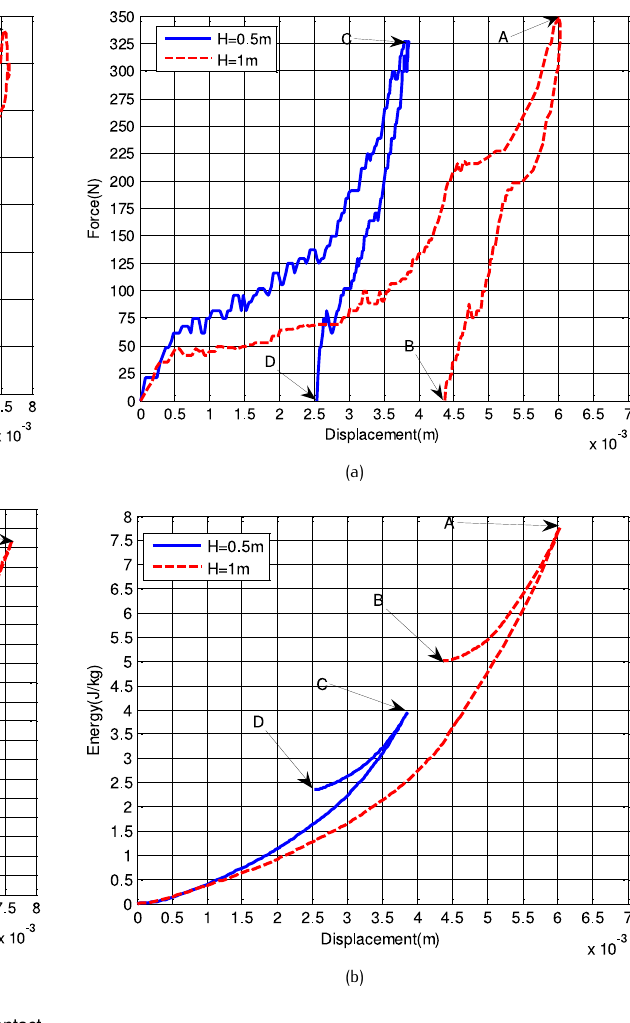
Figure 12. Crushable EPP foam in two drop heights (a): Contact force versus displacement (b): Absorbing energy versus